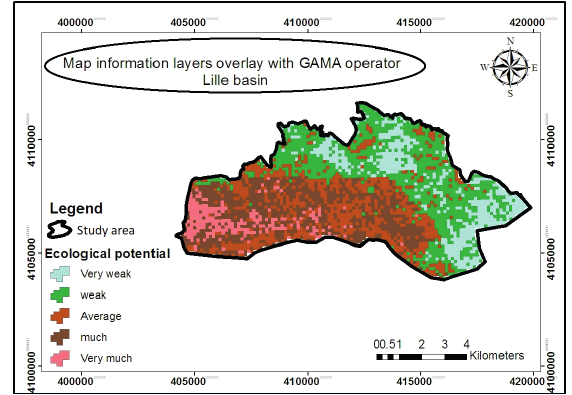
Figure 3 - Overlay map of the information layers using AND